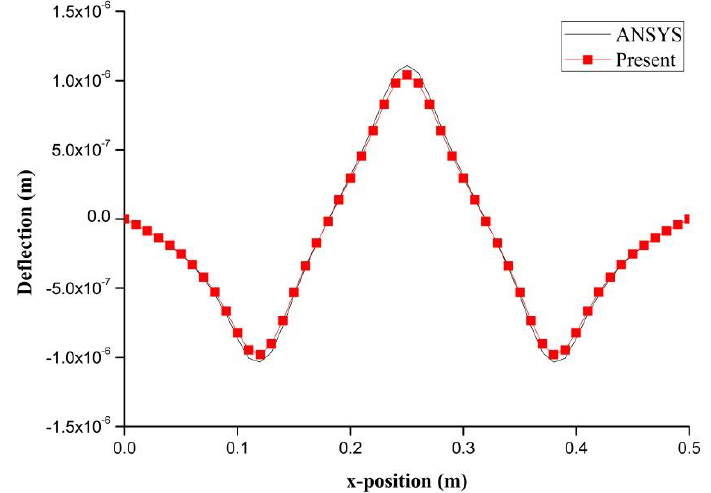
Figure 16. Deformed shape of the composite laminate plate induced by distributed PZT actuators.